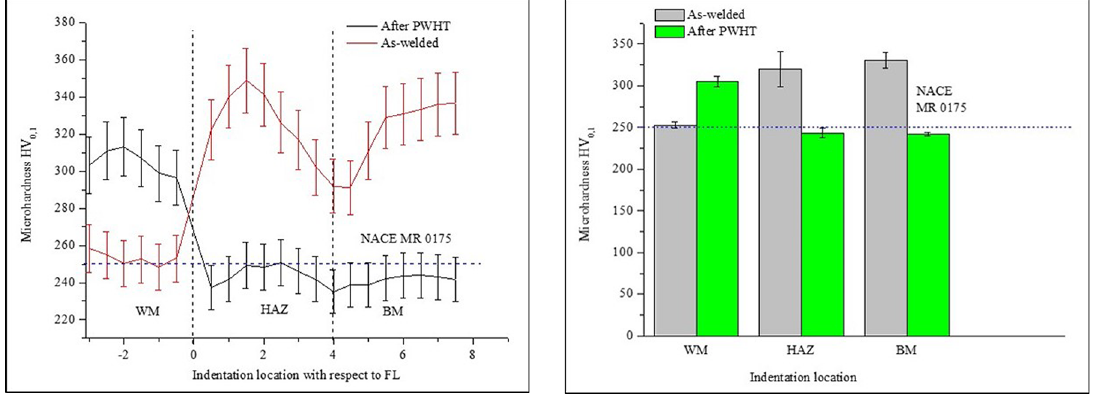
Figure 11. Mean and standard deviation of Vickers microhardness (LAMS), regions of (WM), HAZ and (BM), as-welded and after PWHT. austenite (RA), more examples can be seen in Figure 13 for Δ, Φ and M